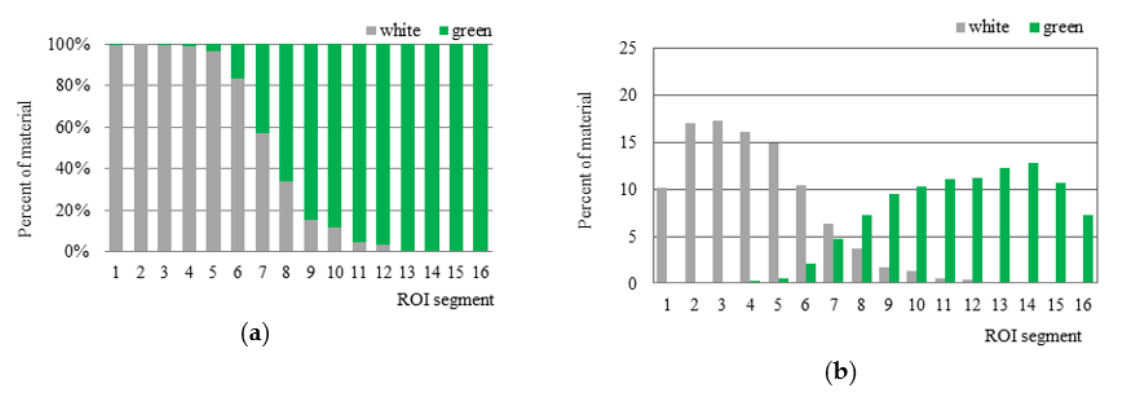
Figure 10. Results after 1 min. of tribocharging and separation: ( a ) percentage of PET and PE-HD in each ROI segments; ( b ) percentage of PET and PE-HD in relation to the surface of the ROI segments.